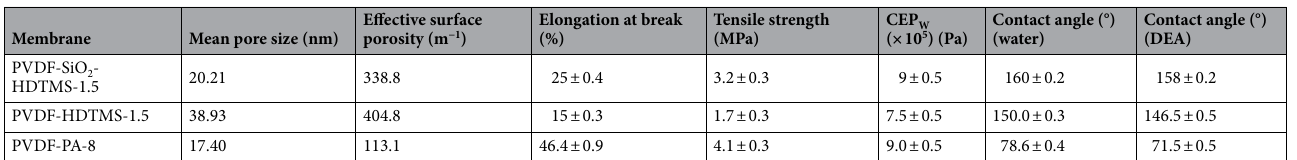
Table 4. Characteristics of the hollow fiber